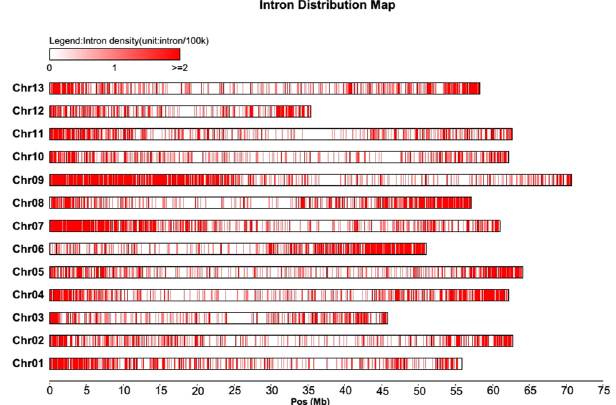
Figure 1. Chromosome distribution of 7,049 genes associated with ILP markers in G . raimondii . Each vertical short bar indicates the position of corresponding candidate gene.